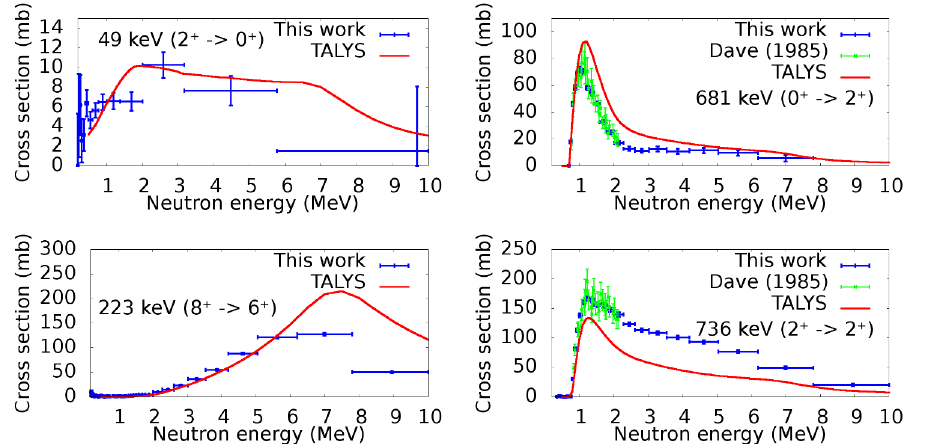
Figure 4. (color online) The (n,n’ γ ) cross sections are chosen as representative of shapes observed. This work is compared with Dave et al. [3] and predictions of TALYS-1.8 with default